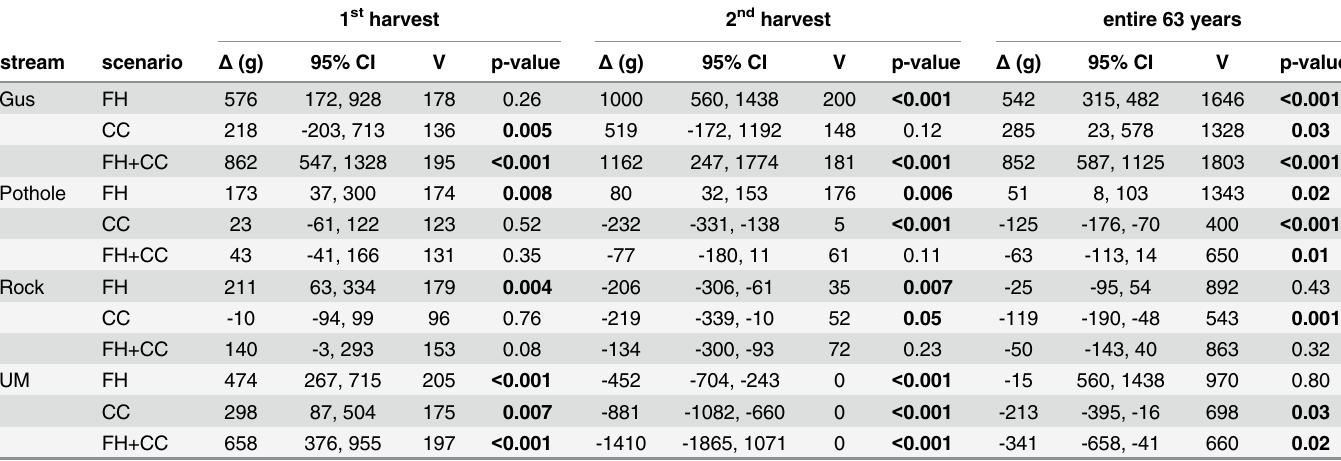
Pairwise comparisons of total biomass (g) of trout in summer for forest harvest (FH), climate change (CC), and combined (FH + CC) scenarios compared to baseline in modeled streams, including Gus Creek, Pothole Creek, Rock Creek, and Upper Mainstem (UM). Values of summer biomass by year were averaged for fi ve replicate simulations and were analyzed using Wilcoxon signed rank test (V) with continuity correction resulting in a pseudomedian of difference between scenario and baseline ( Δ ) for the 1 st harvest period, 2 nd harvest period, and the entire study period. Scenarios include manipulations of stream temperature and fl ow regimes (see Methods for details). Signi fi cant p-values in bold (alpha (cid:3) 0.05) represent increasing or decreasing magnitudes in comparison to